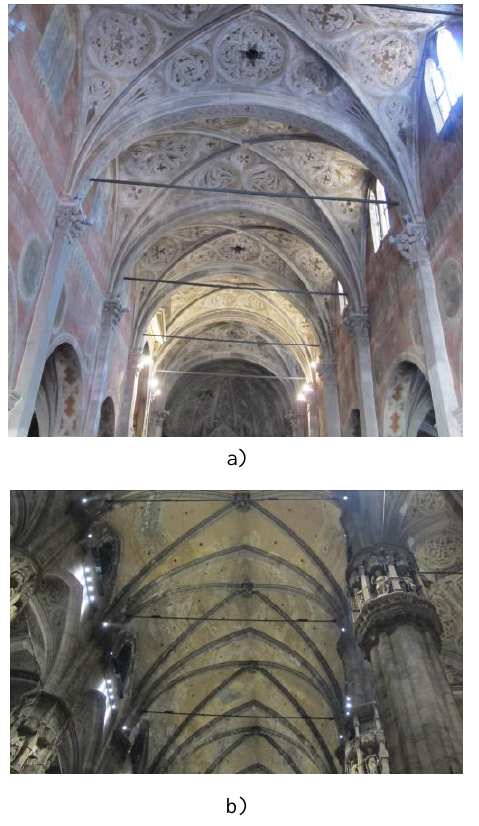
Figure 1. View of masonry vaults in the central nave: a) Church